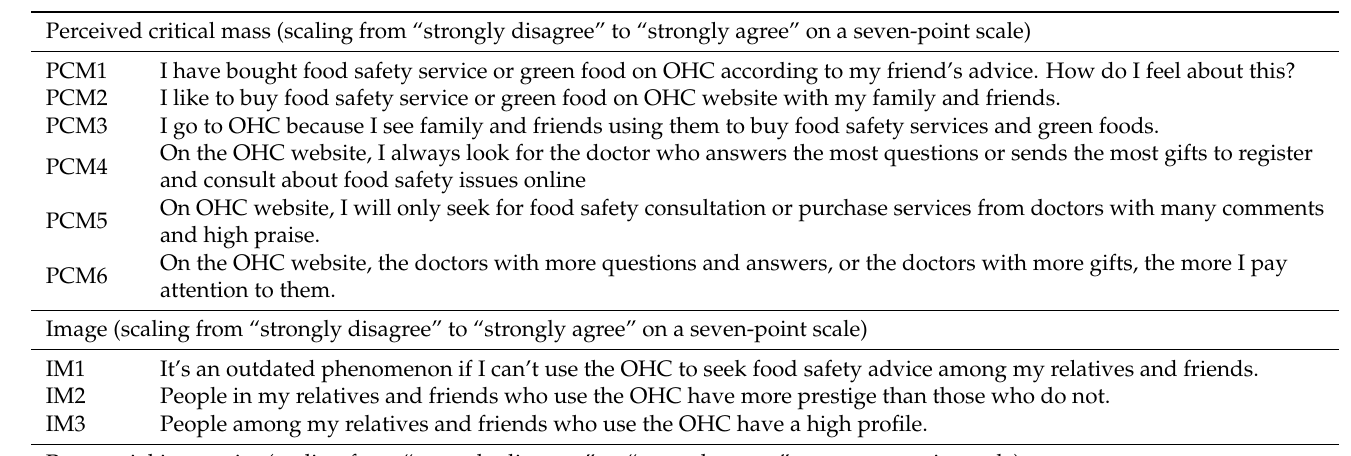
Table A2. Questionnaire